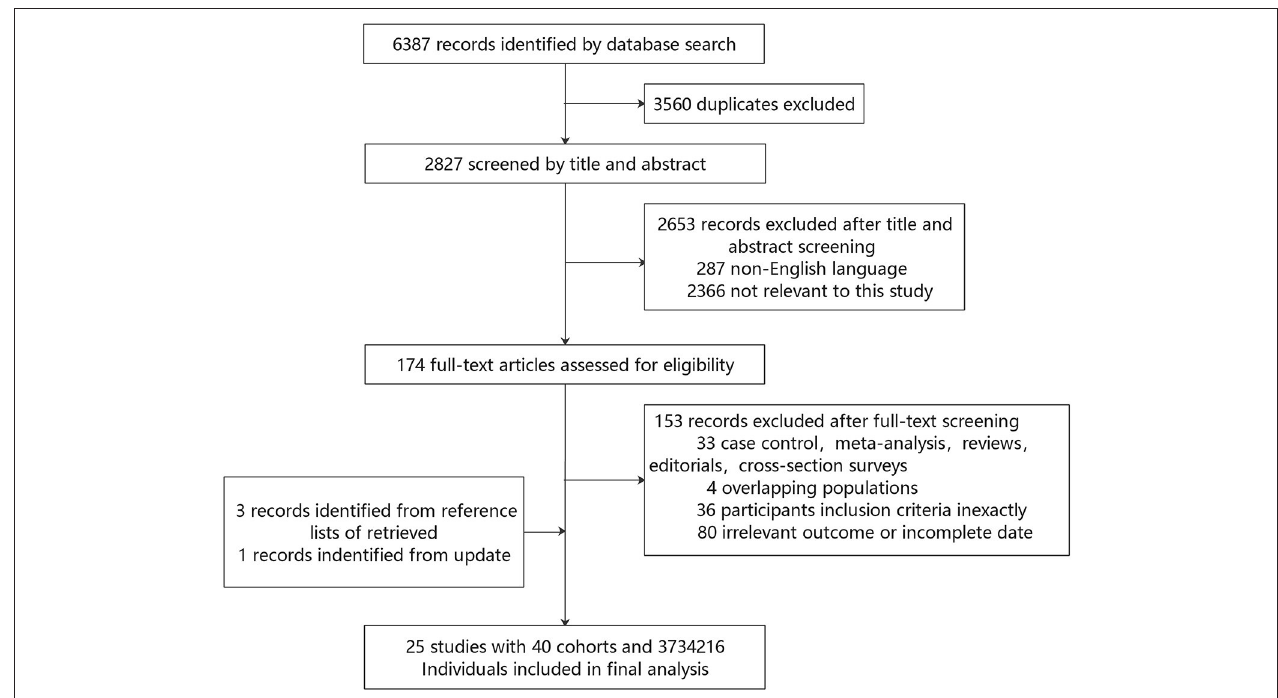
FIGURE 1 | Flow diagram of the literature